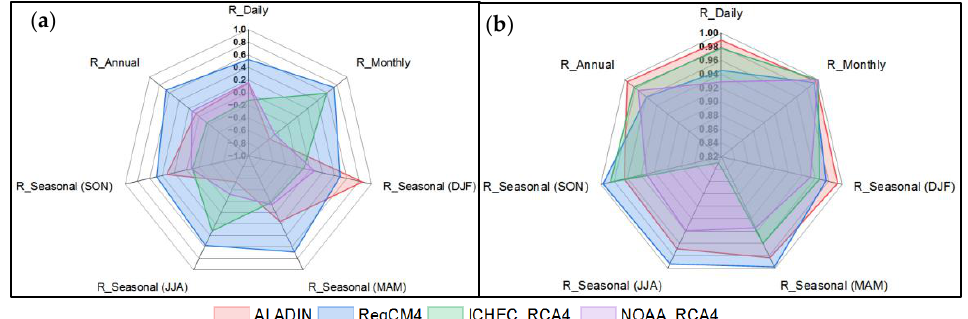
Figure 11. Radar charts of spatial correlation coefficients R in different time steps. ( a ) Raw RCMs; ( b ) corrected RCMs.